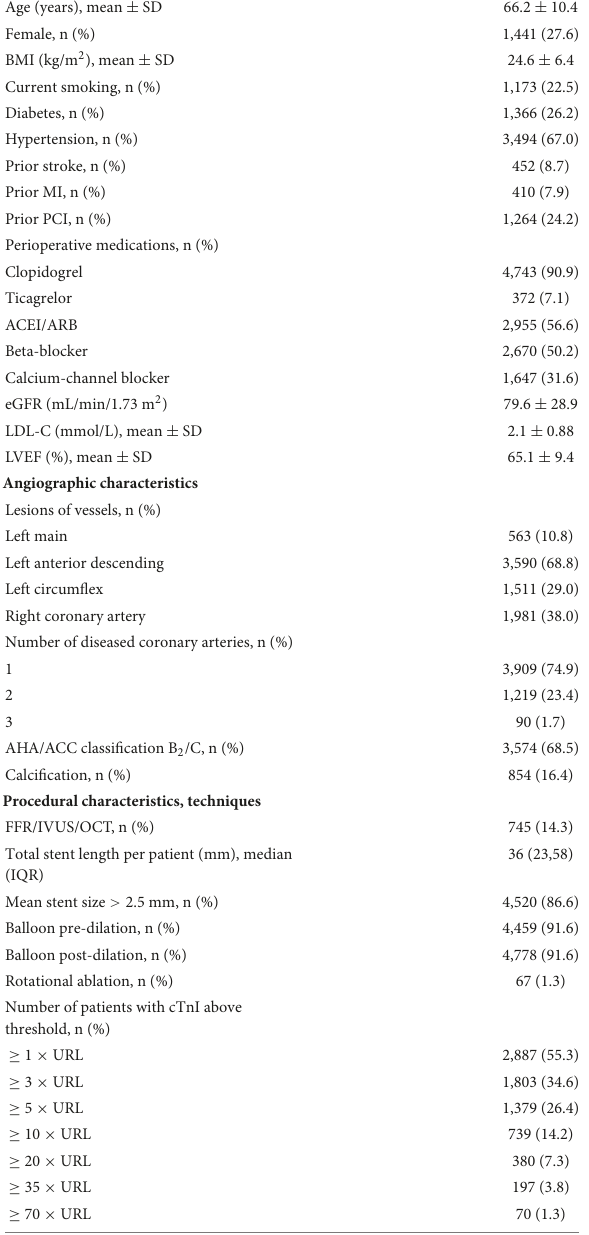
TABLE 1 Baseline clinical characteristics, angiographic characteristics, and procedural characteristics of the study population ( N = 5,218).